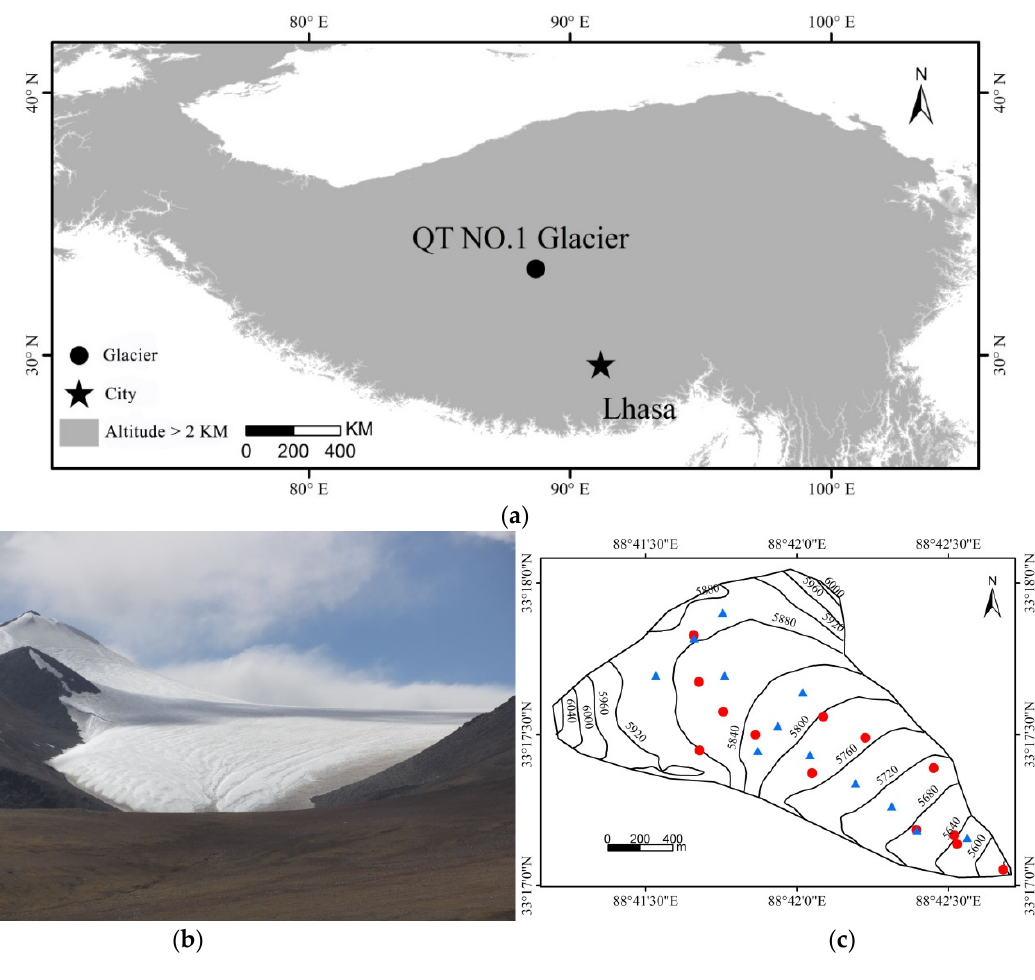
Figure 1. ( a ) Geographical location of QT No. 1 Glacier, ( b ) the state of the glacier’s surface on 4 June 2014, and ( c ) a contour map showing observation points across the QT No. 1 Glacier. Red circles show the locations of observations made in 2013, whereas blue triangles show observation points for 2014 and 2015.